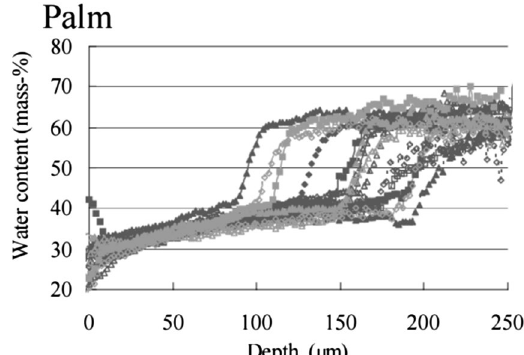
Figure 3. The epidermis water concentration profile as a function of the palm skin’s depth measured in the palm of the hand of 15 subjects. The sharp rise in water content from approximately 40% to 65% mass represents the boundary between the epidermis and the dermis of the subject. The measurements were made in vivo, where Raman spectra were obtained at different depths below the skin surface using a confocal Raman spectrometer. The average depth of the epidermis was 173 μm with a standard deviation of 37 μm. (Reproduced with permission 21 . Published in Acta Dermato-Venereologica for the Society for Publication of Acta Dermato- Venereologica. All rights